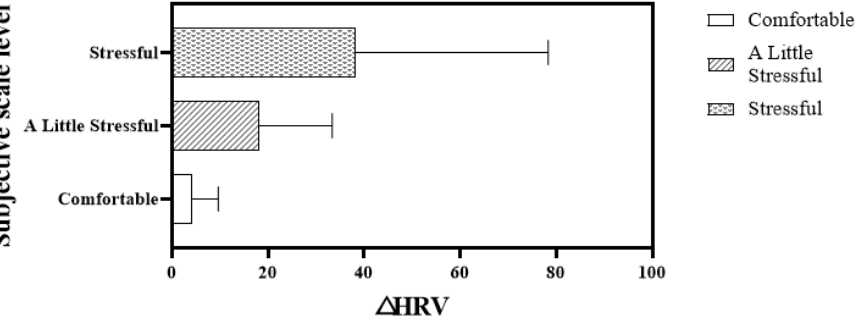
Figure 7. Distribution of ∆ HRV and subjective scale